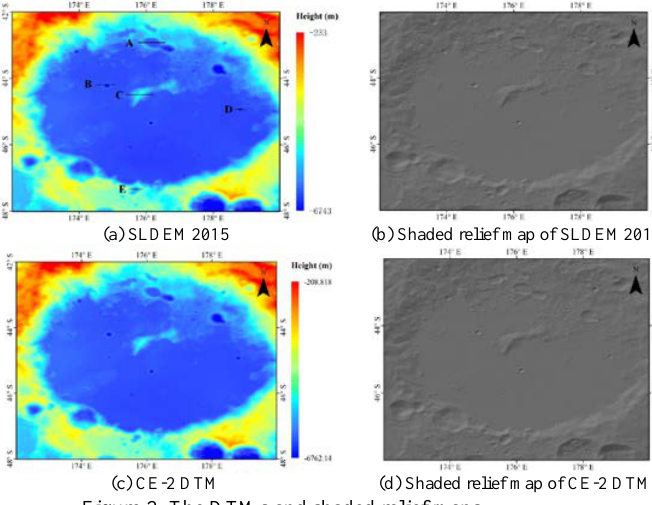
(d) Shaded relief map of CE-2 DTM Figure 2. The DTMs and shaded relief maps The original DTM of CE-2 and the registered DTM of CE-2 were subtracted from SLDEM2015 pixel by pixel, respectively. Figure 3 (a) shows that the height different between original CE-2 DTM and SLDEM2015 are widely distributed. most of the difference are bigger than 200 m among the craters. (b) shows that after matching the differences are mostly in the range